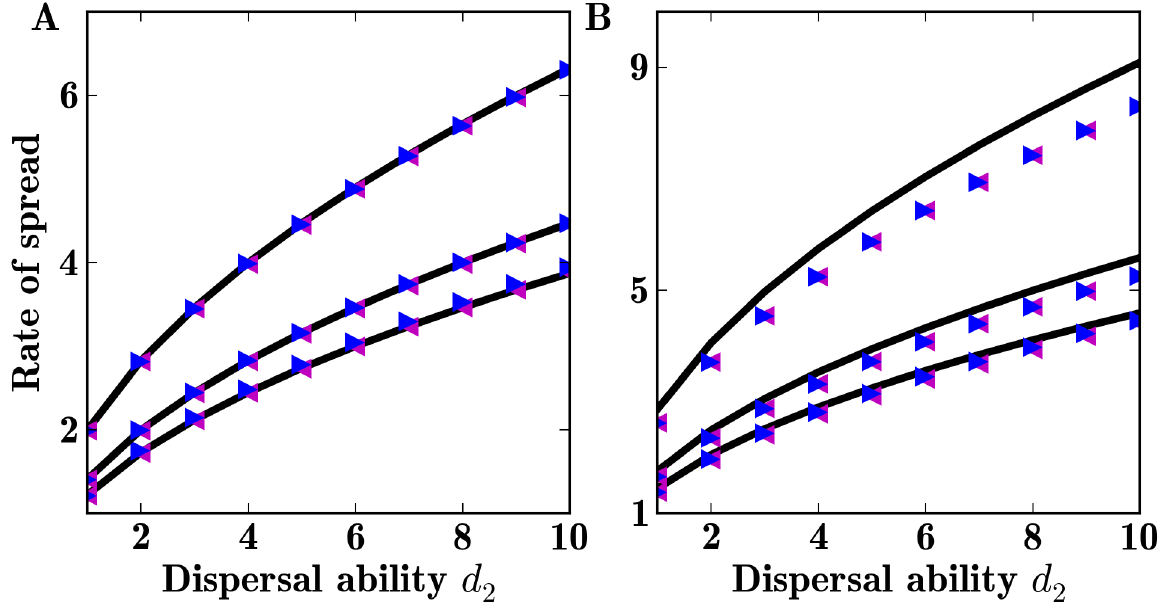
Figure 2. Asymptotic rate of spread of a population with two dispersal abilities. Theoretical (black lines) and computed asymptotic rate of spread when two dispersal abilities are present in the population. Initial propagules are u 1 (0,0) ~ 0 : 99, u 2 (0,0) ~ 0 : 01 (blue triangle) and ~ 1 (1) r ~ 0 : 75 (2) r ~ 1 and (3) r ~ 2 . A: Using Gaussian dispersal u 1 (0,0) ~ 0 : 999, u 2 (0,0) ~ 0 : 001 (magenta triangle). Other parameter values are d 2 1 kernels. B: Using Laplace dispersal kernels.